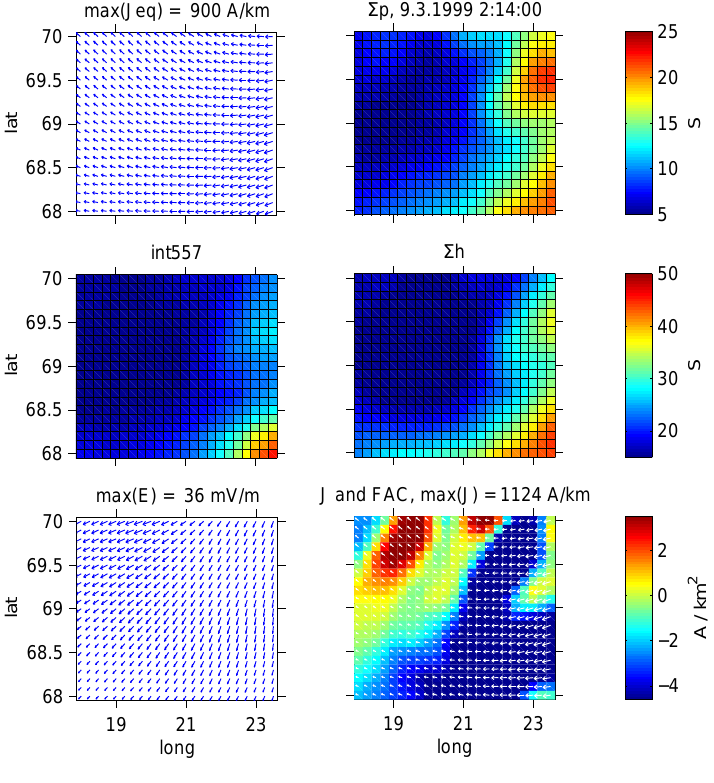
Fig. 7. Similar to Fig. 6, but here we use the emap conductance estimate and time is 02:14:00UT. Here the auroral 557 nm intensity is from Kilpisj¨avi station, corresponding to Fig. 5. The area shown in this figure is indicated by the red rectangle in the top left panel of Fig.